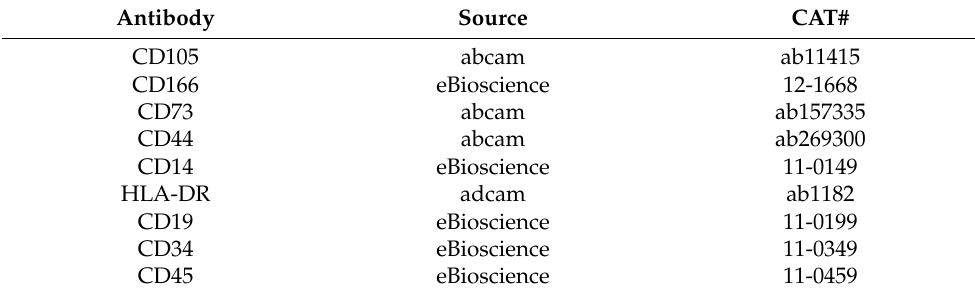
Table 1. Antibody